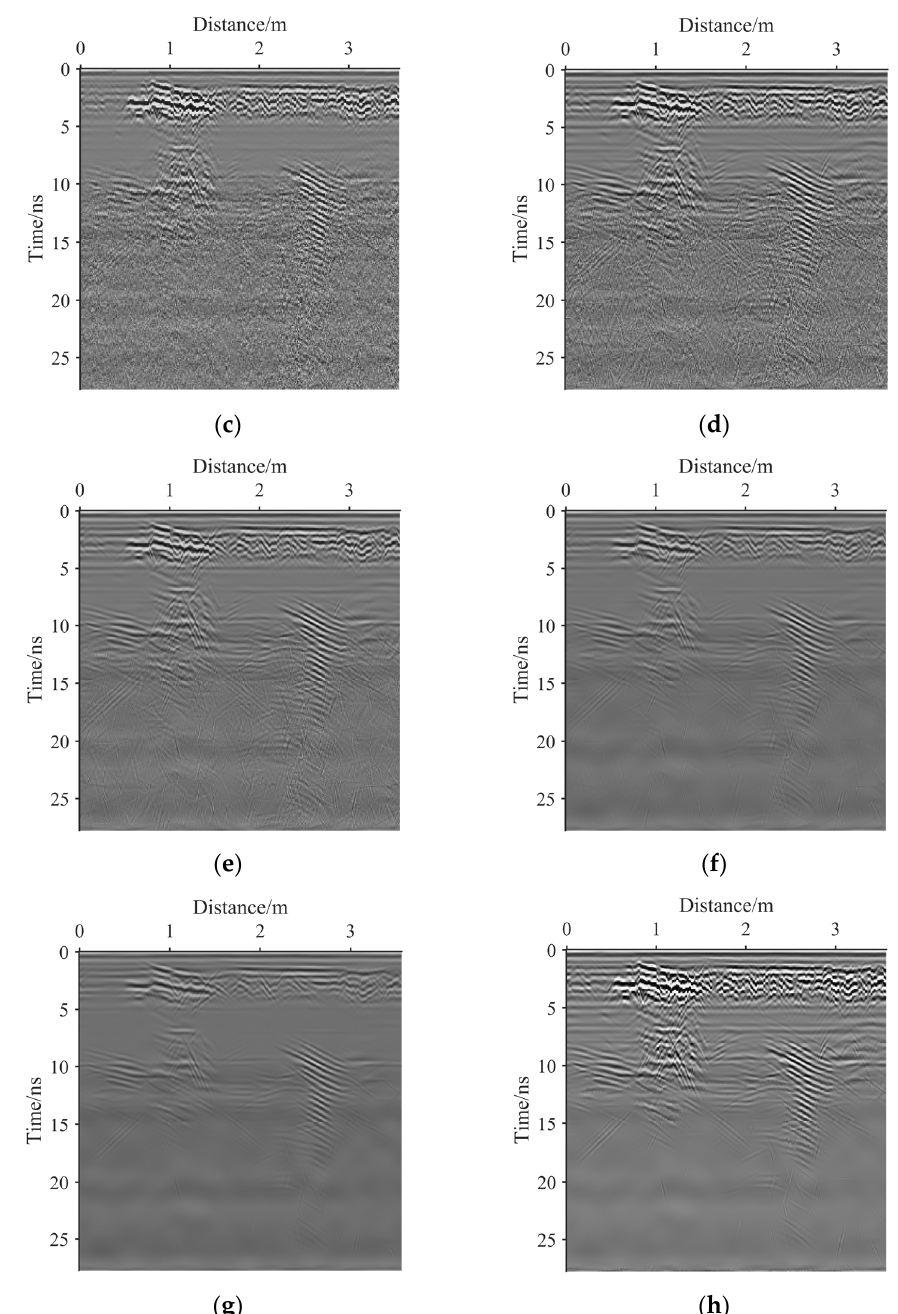
Figure 11. ( a ) The original real GPR image 1. ( b ) The result of bilateral filter. ( c ) The result of guided filter. ( d ) The result of NSST ‐ 1. ( e ) The result of NSST ‐ 2. ( f ) The result of NSST ‐ 3. ( g ) The result of NSST ‐ 4. ( h ) The result of the proposed method. NSST-2: e and Figure 12e show the noise removal results of NSST with a noise standard deviation of 20. The edge information destruction at 0–5 ns and 10–15 ns is more severe than that from NSST-1. The residual noise at 15–25 ns is less than that from NSST-1. This is because the selected noise standard deviation is greater than that in the case of NSST-1. The noise standard deviation of 20 is large for shallow underground noise but small for deep underground